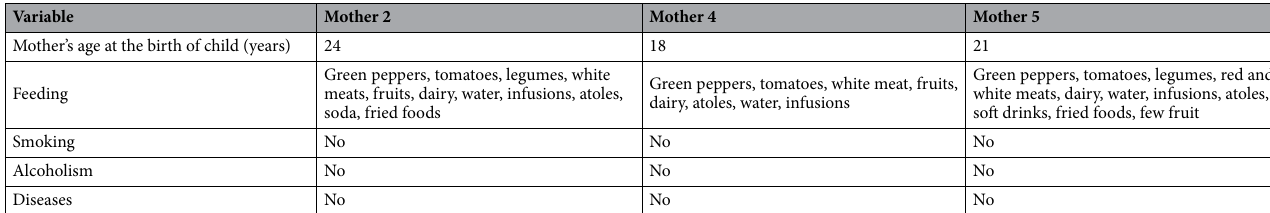
Table 2. Characteristics of the participating